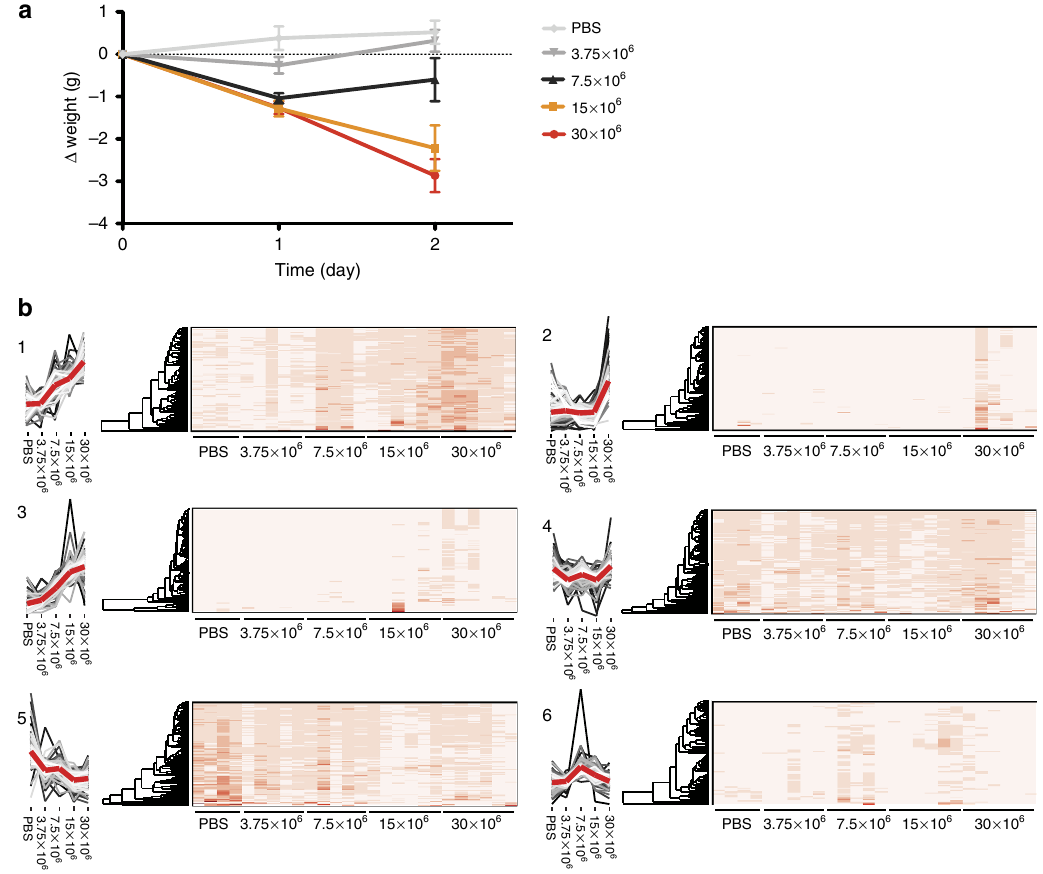
Figure 4 | Quantitative changes of blood plasma proteins during severe Sepsis. In total, 26 animals were inoculated with S. pyogenes bacteria using different infectious doses (3.75 (cid:2) 10 6 , 7.5 (cid:2) 10 6 , 15 (cid:2) 10 6 and 30 (cid:2) 10 6 ) or PBS as control. The animals were killed after 48h and citrated blood was collected using cardiac puncture. The blood plasma proteins were digested with trypsin followed by DIA-MS analysis. ( a ) Average weight loss of the animals within the dose groups of inoculated mice. ( b ) The proteins were clustered using t-SNE dimensionality reduction followed by PAM clustering and the abundance profiles for the six groups shown as line graphs in 1–6. The denser part of the graph is shown as increasing lighter coloured lines. The average intensity profile across the groups is shown as a thicker red line. The relative protein abundance for the individual animals are shown using heat